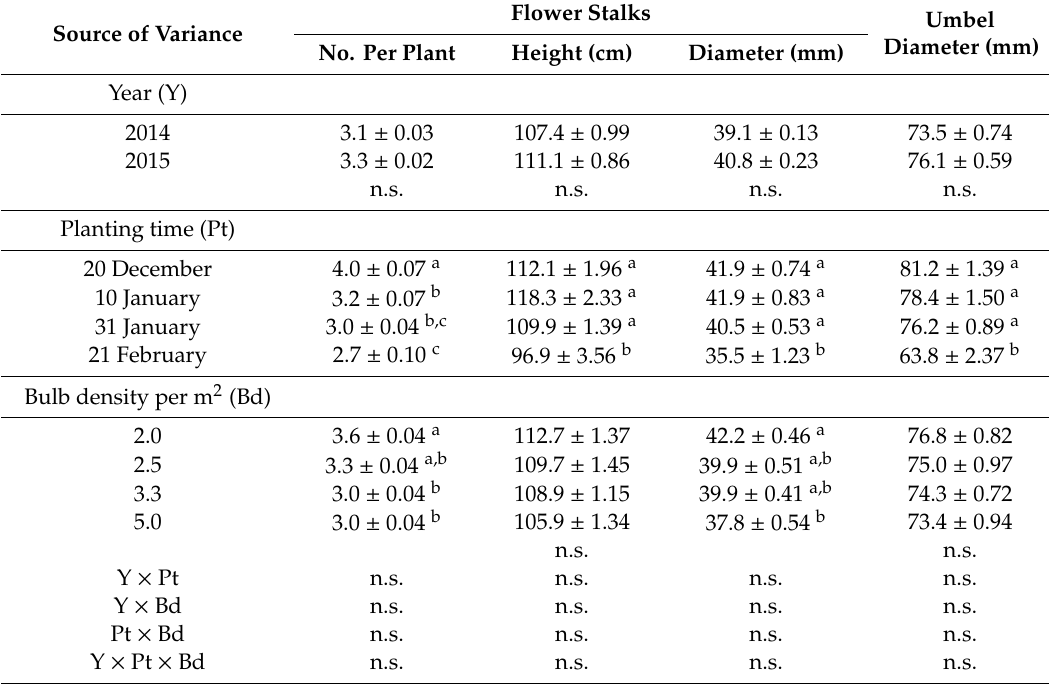
Table 1. Mean values of onion biometrical parameters at harvest as a ff ected by bulb planting time and density ( n = 3 ±